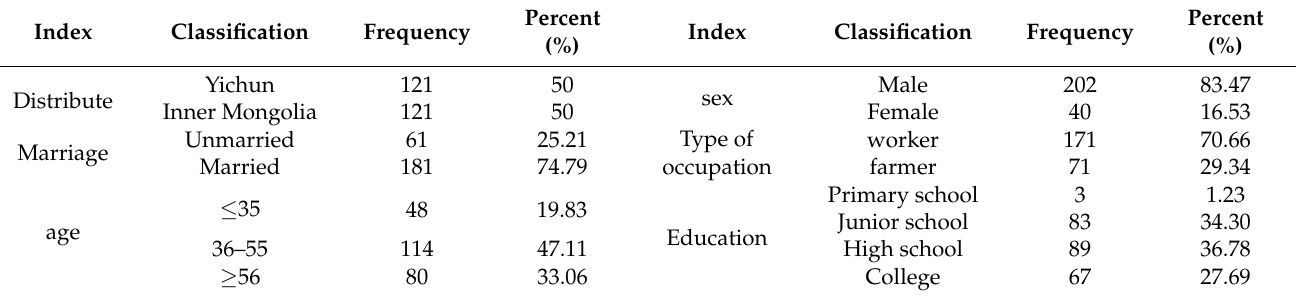
Table 1. Basic characteristics of